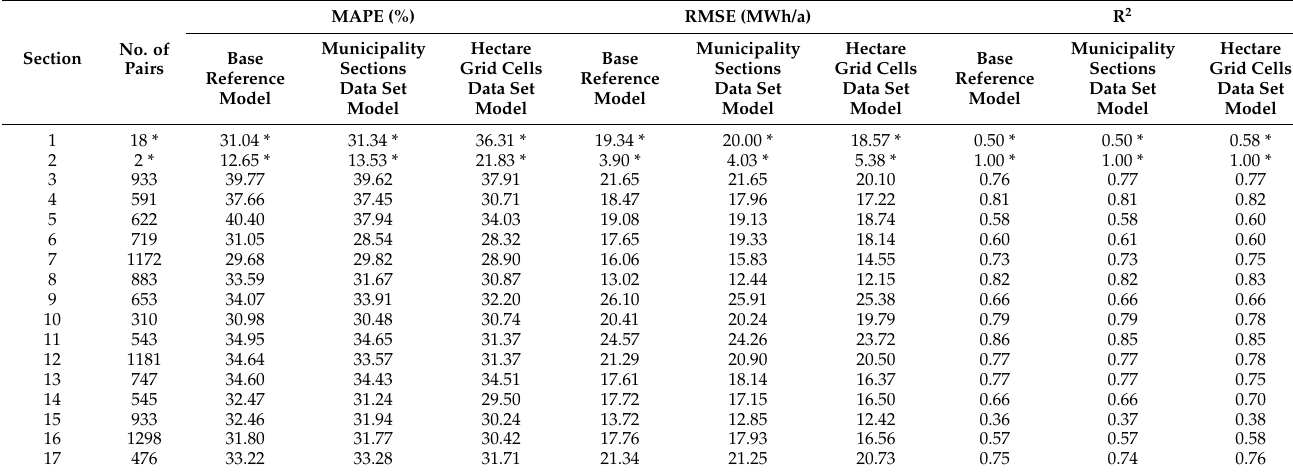
Table 4. Statistical measures stating prediction accuracy on the municipality section level when validating modeled residential building heat demand with gas consumption data via address-based